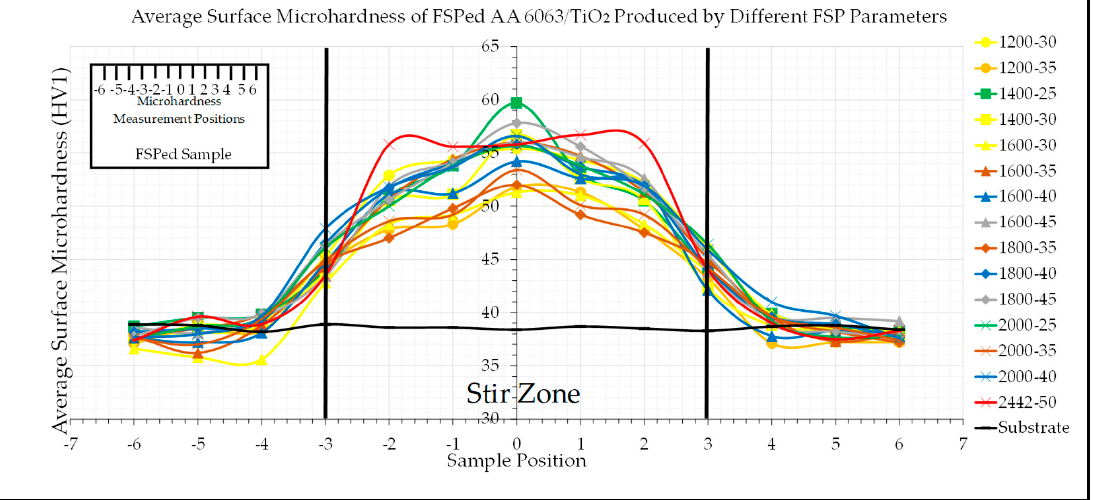
Figure 13. Average surface microhardness of substrate material and FSPed recycled AA 6063/TiO 2 produced by different processing parameters.